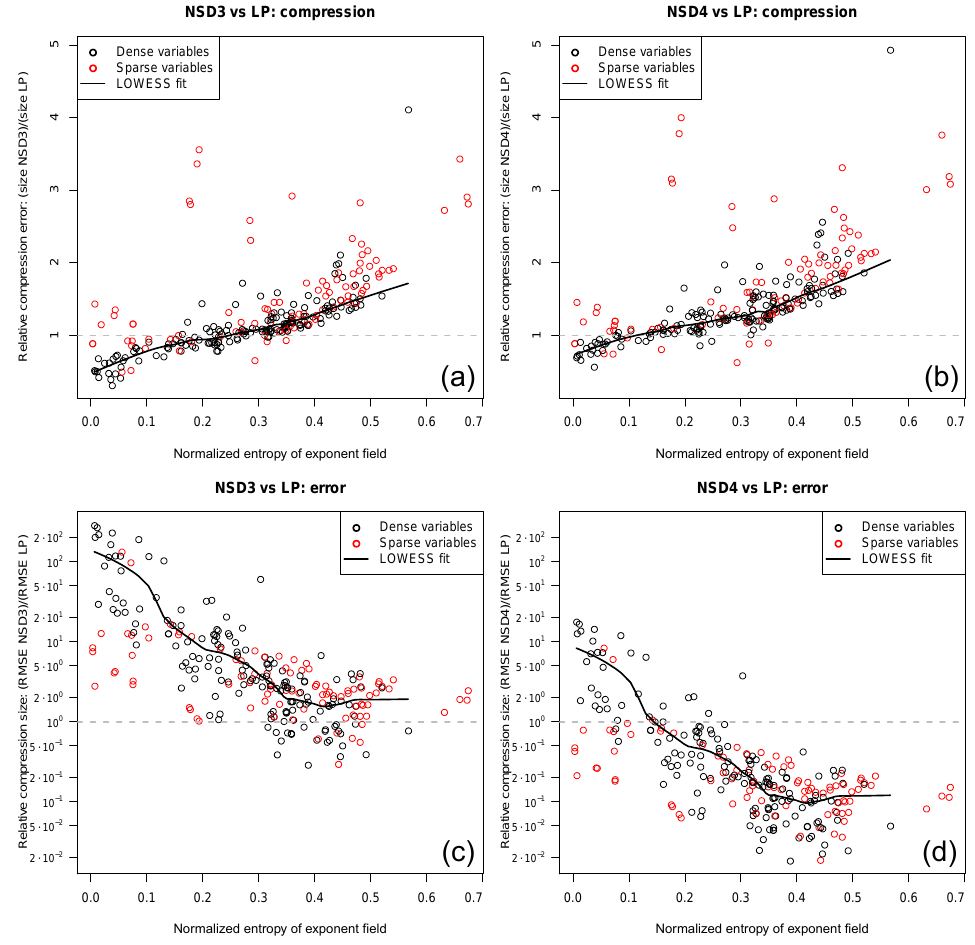
Figure 3. Relative performance of LAY compared with NSD3 (left column) or NSD4 (right column), in terms of compression (top row) and errors (bottom row). The grey dashed line indicates values of 1.0 on the y axis. The LOWESS fit was based on the dense variables alone.